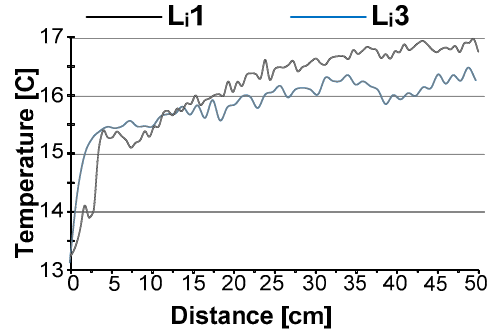
Figure 4. Temperature distribution in color scale on the wall surface from the side of heat inflow ( a ) without thermal insulation ( b ) with thermal insulation from the inside.